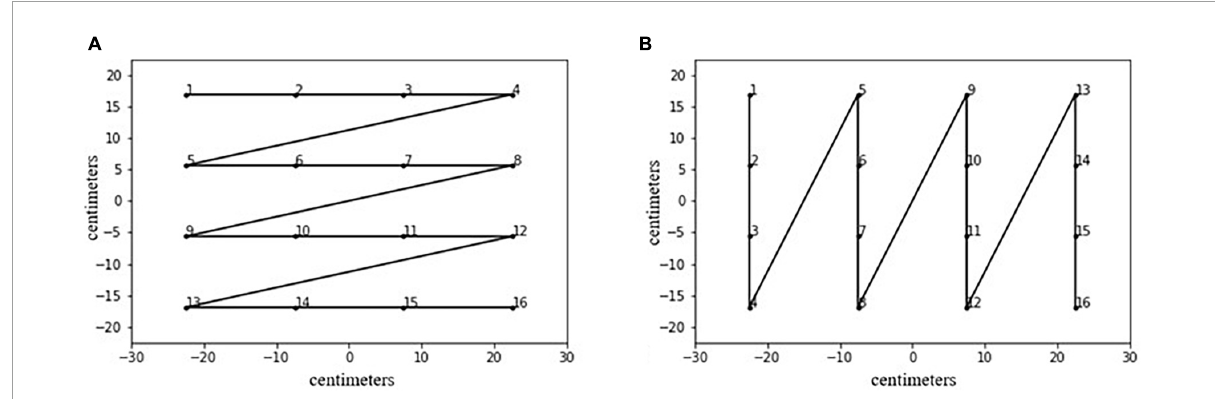
FIGURE3 The two optimal sequences used. The first is a sawtooth by rows (A) ; the second is a sawtooth by columns (B)